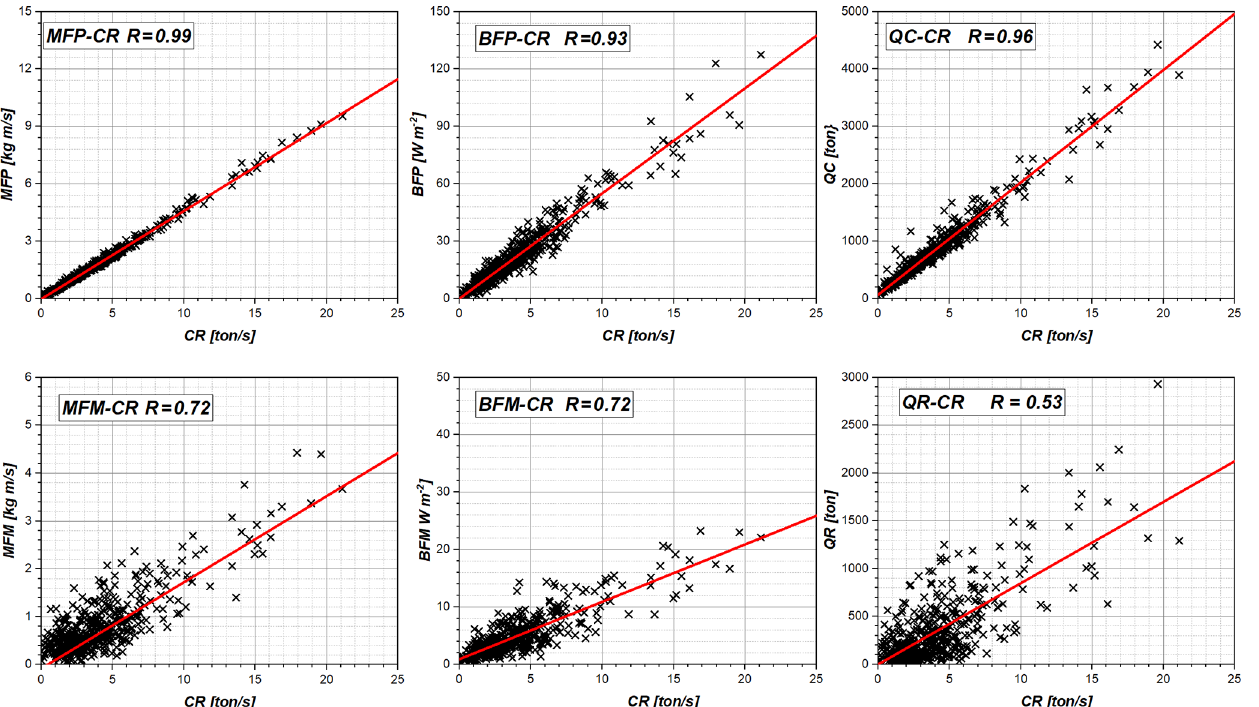
Figure 2. Correlation of condensation rate (CR) with parameters denoted in plot legends. Group G2 R is the correlation coefficient.